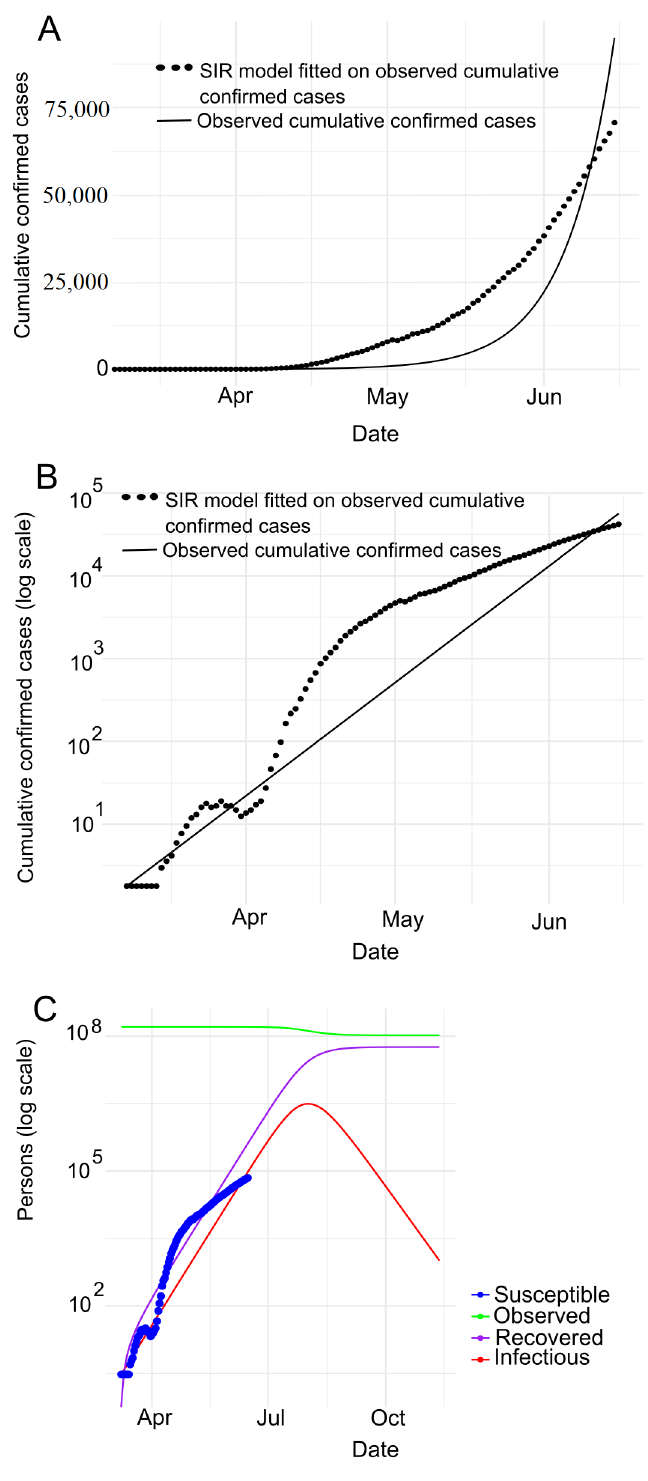
Figure 4. Prediction with SIR model for Bangladesh: ( A ) SIR model fitted on observed cumulative infected cases ( B ) SIR model fitted on observed cumulative infected cases with semi log scale ( C ) SIR model prediction with no human